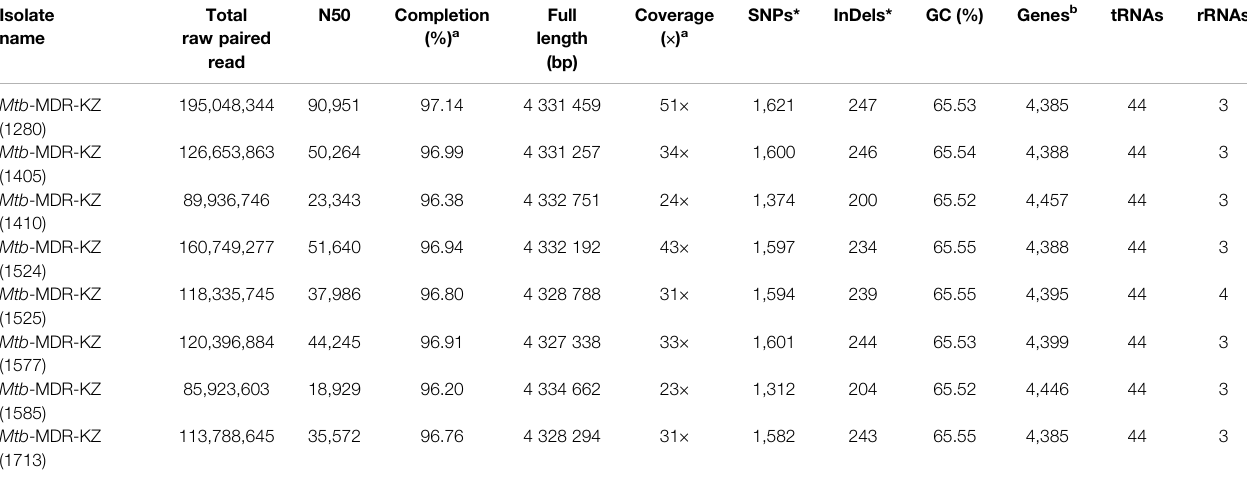
TABLE 1 | Whole-genome mapping and sequencing statistics of eight Kazakhstan Mycobacterium tuberculosis isolates. Isolate